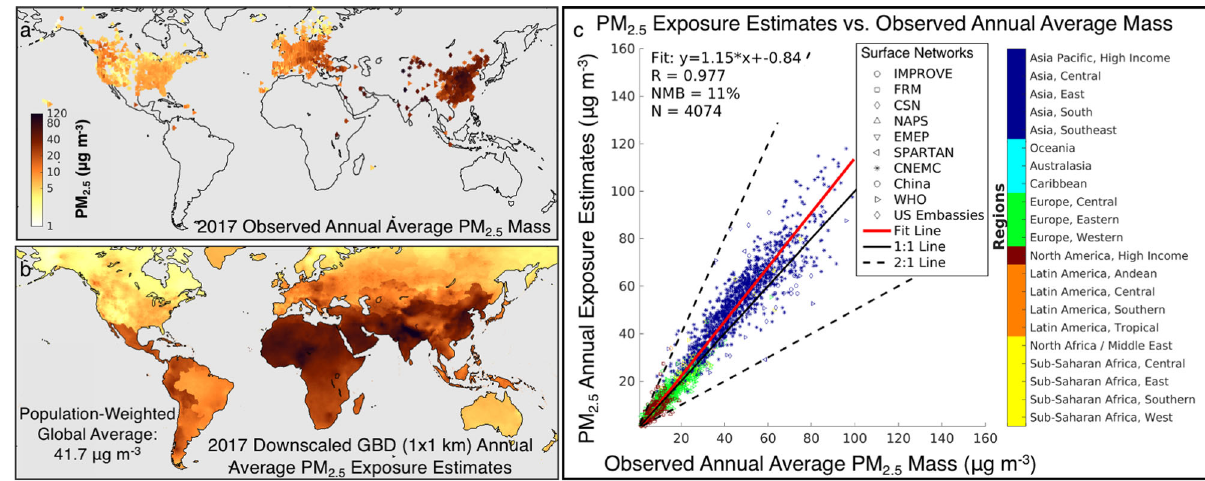
Fig. 1 Evaluation of PM 2.5 exposure estimates relative to surface observations. a Annual average observations of total PM 2.5 mass in the year 2017; symbol shapes correspond to monitor network. b Annual PM 2.5 exposure estimates for 2017, downscaled to 0.01° × 0.01° resolution. c Correlation between the 2017 exposure estimates and observed annual average concentrations, colored by Global Burden of Disease (GBD) region (Supplementary Table 1); symbol shape corresponds to the observation network; correlation slope, intercept, coef fi cient, normalized mean bias (NMB), and number of observation points are provided. (NMB = 100* Σ (exposure estimate − observations)/ Σ